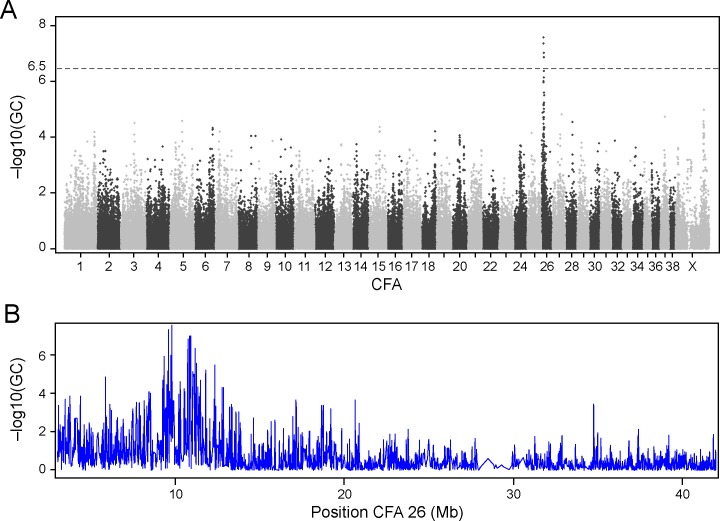
Across-breed GWAS for glioma identified a strongly associated locus on chromosome 26.Log p-values on the y-axis are adjusted for stratification by genomic control (GC). A significantly associated locus was found on CFA 26 (A) spanning the region of CFA 26:8.5–12 Mb (B). Dashed line at log p-value 6.5 corresponds to p-value 0.05 after Bonferroni correction (A).